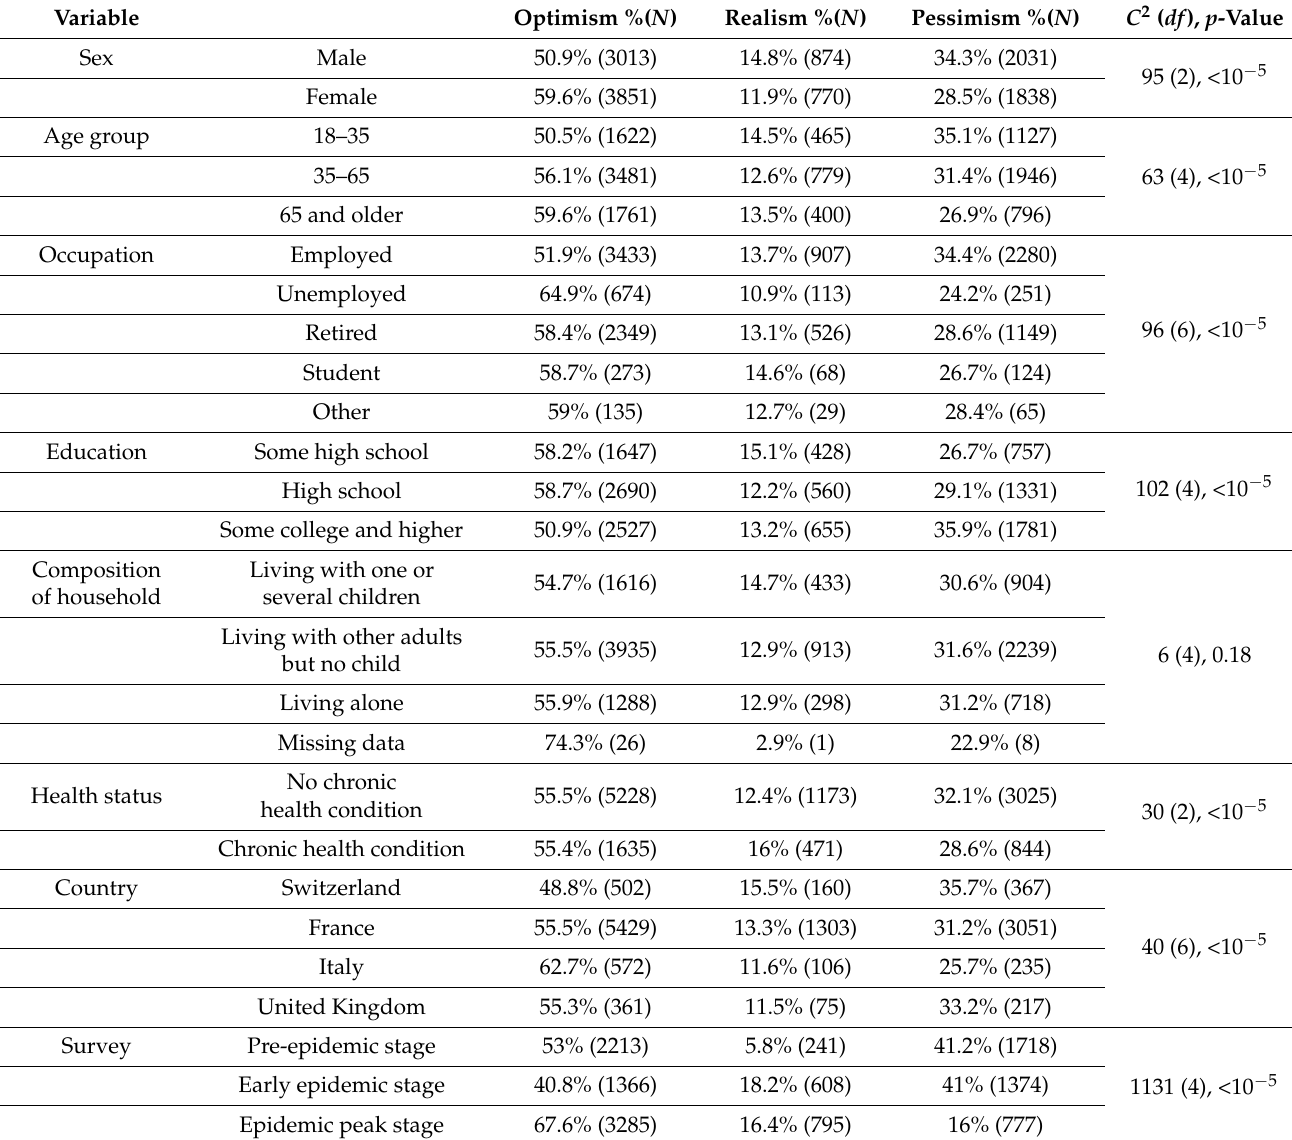
Table 3. Distribution of optimism, realism and pessimism related to SARS-CoV-2 infection in a variety of subpopulations and settings: numbers and